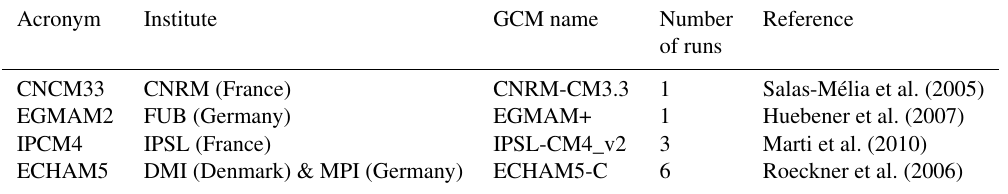
Table 2. Statistical downscaling methods. Acronym Description Weather types + transfer functions Boé et al. (2006) d2gen22 Transfer functions + analogues Mezghani and Hingray